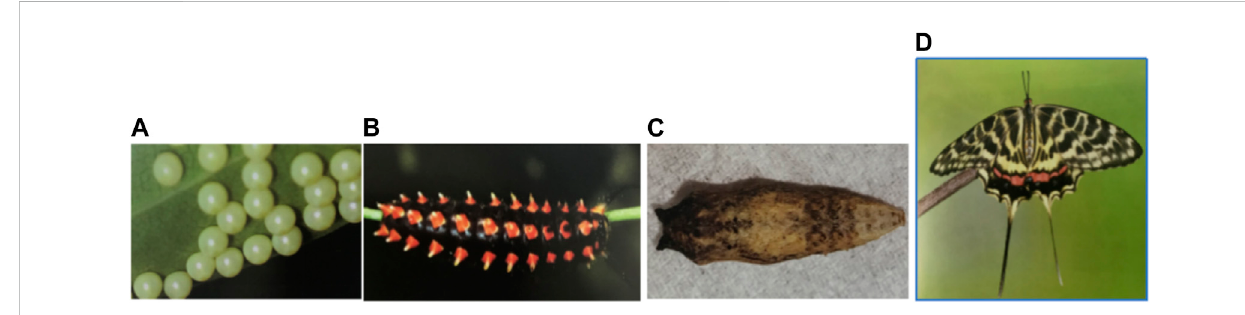
FIGURE 1 Four phases of the complete life history of S. montelus : egg, larva, pupa, and